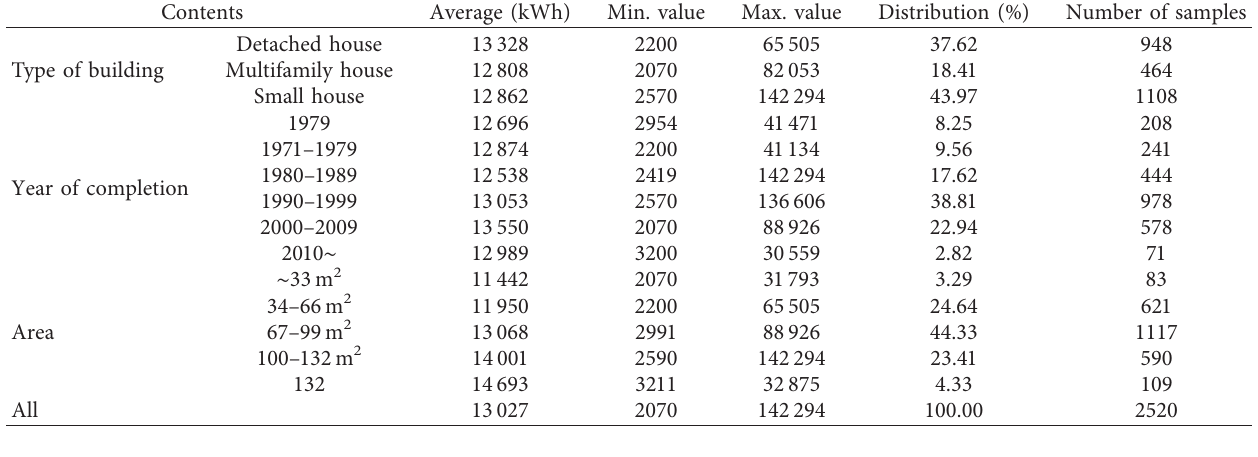
Table 15: National statistics on energy consumption data (kWh).